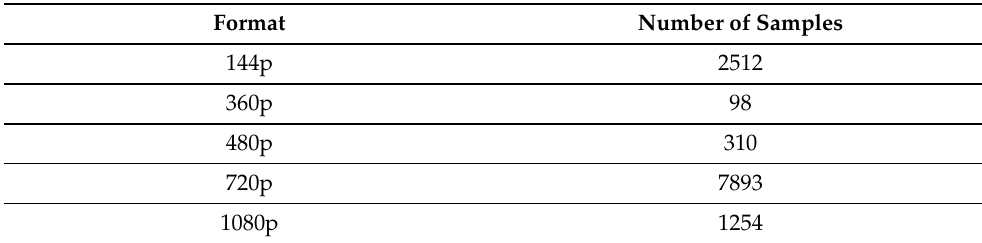
Table 1. Sample format